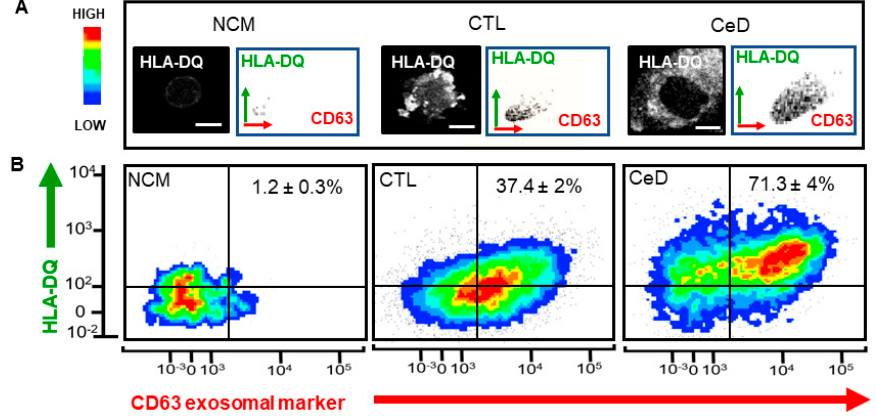
Figure 3. Enhanced exosomal HLA-DQ in T cells exposed to conditioned growth media (CGM) from CeD-sourced MoDCs. ( A ) Representative black and white confocal micrographs of HLA- DQ (DQ; white signal) within a T cell exposed to non-conditioned growth media (NCM) or CGM. Scale bar = 10 µ m. Side scatter (SSC) plots of T cell populations from upper-right-quadrant gating ( B ) demarcating predominant fraction with HLA-DQ within CD63-labeled exosomes. Left: Naïve T cells, i.e., exposure to NCM; middle: T cells exposed to CGM from monocyte-derived dendritic cells (MoDCs) from healthy individuals—CTL; right: T cells exposed to CGM from MoDCs from CeD patients—CeD. ( B ) Dot blot density cytograms of FITC conjugated HLA-DQ versus APC-conjugated CD63 providing an indication of signal intensity and extent of CD63 exosomal colocalization. The blue/green/yellow/red/hot spots represent increasing numbers of events (low to high) resulting from discrete cell populations. Percentage cell count per total T cell population data shown.